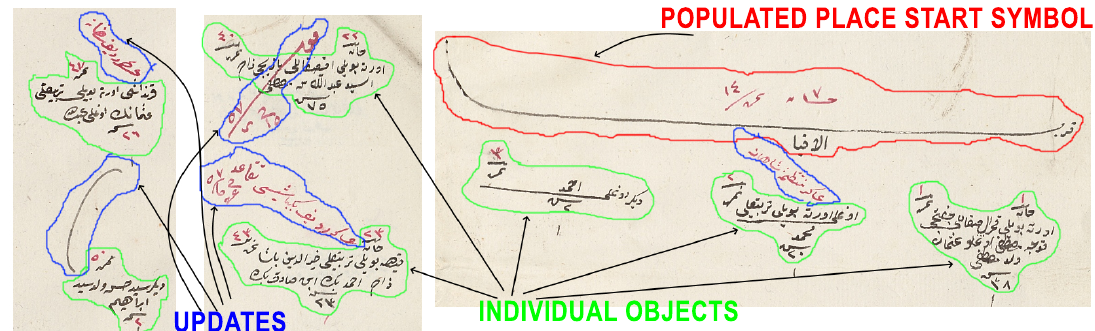
Figure 3. Example updates of registers are shown. Some of them can connect two individuals and can cause clustering errors. Green enclosed objects are individuals; red ones are populated place symbols; and blue ones are the updates connecting two other object